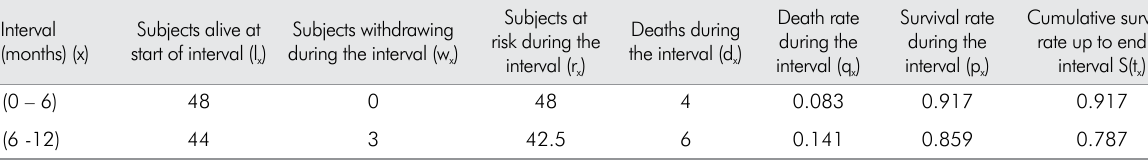
Table 2. Actuarial methods for assessing protective restoration Interval (months)